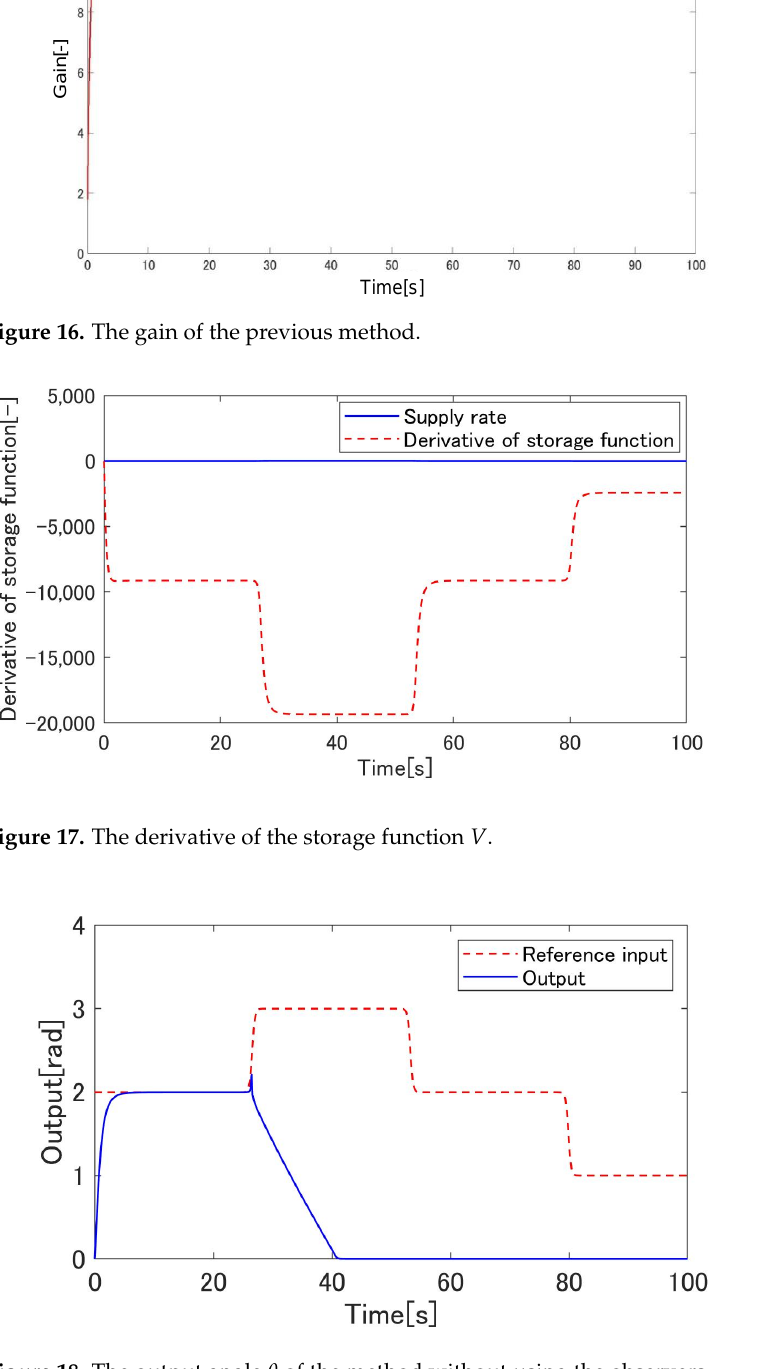
Figure 18. The output angle θ of the method without using the